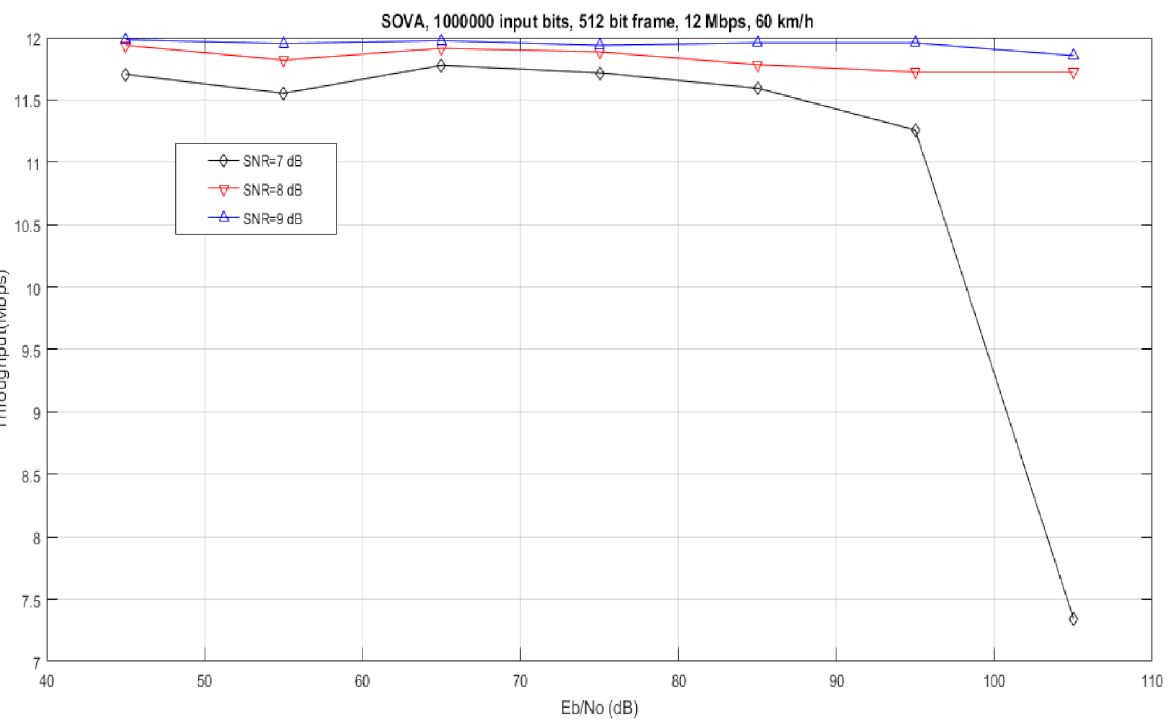
Figure 7. BER vs. Vehicle density for GEMV channel, 6 different SNR values, 12 Mbps data rate, 60 km/h mobile terminal speed, SOVA algorithm, 3 iterations, frame length of 512 bits.